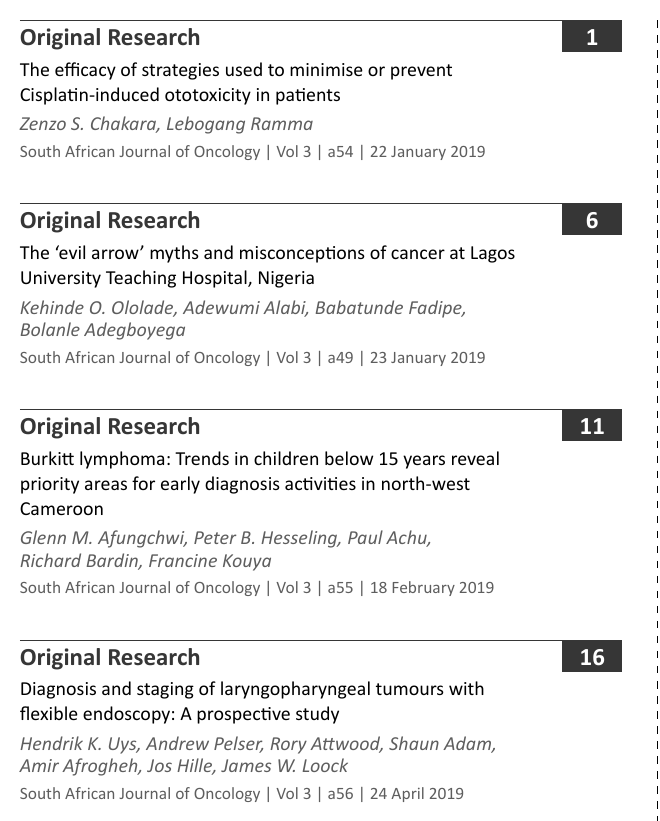
Original Research The efficacy of strategies used to minimise or prevent Cisplatin-induced ototoxicity in